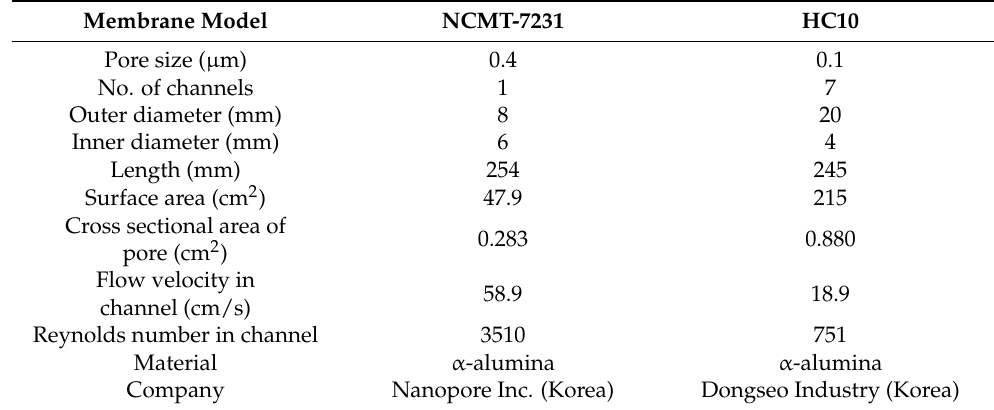
Table 1. Specification of tubular and seven channel alumina ceramic MF membranes employed in this experimental research.